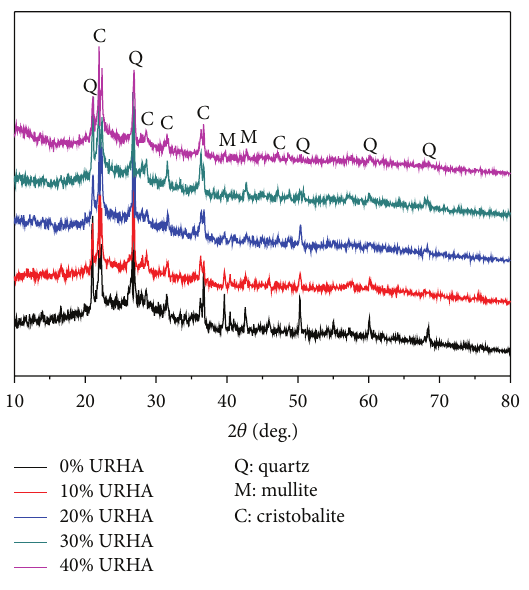
Figure 7: XRD patterns of brick samples at various URHA replace- ment